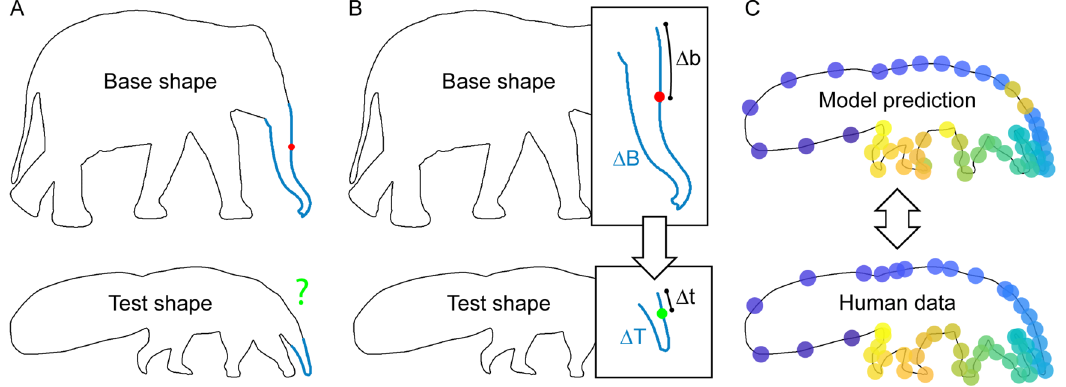
Figure 8. Illustration of our extended model. The model is based on the identified parts, their semantic labels and the semantic correspondences from Experiment 3. ( A ) First, for each probe point, we identify the part on the base shape it’s located on. Second, we find the corresponding semantic part on the test shape (using labels and semantic correspondences). ( B ) Third, we define the position of the probe point relative to the start and end of the semantic part by calculating its proportion of the length of the semantic part contour ( p = ∆b/∆B) along the heading direction (as determined by the similarity in ordering of corresponding semantic parts). Fourth, we predict the test point by using that proportion to define its position relative to the start and end of the corresponding semantic part on the test shape (∆t = ∆T*p). ( C ) From this we obtain a singular predicted location on the test shape for each probe point. By comparing that prediction to the median human response and averaging across all points, we get a prediction accuracy score for each pair of